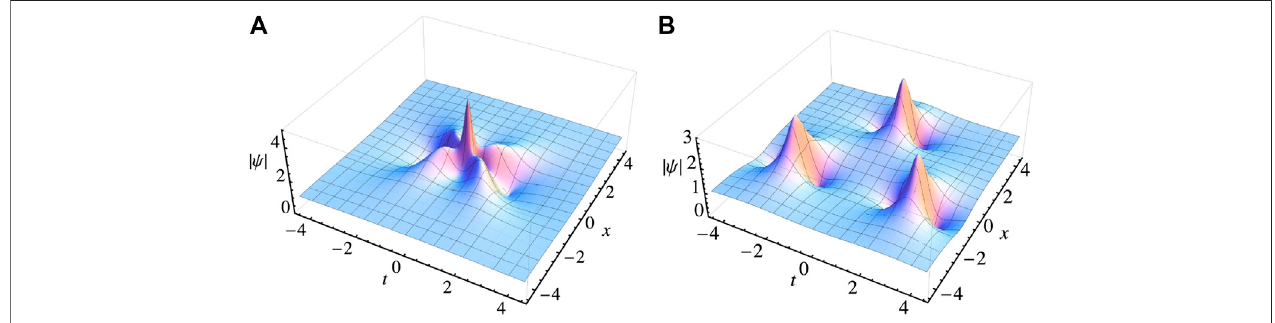
FIGURE 2 | (A) AP solution of the second order [15]. (B) Rogue wave triplet with parameters c (cid:2) 200 and β (cid:2) 0 [73]. Here, the second order solution consists of three Peregrine waves.